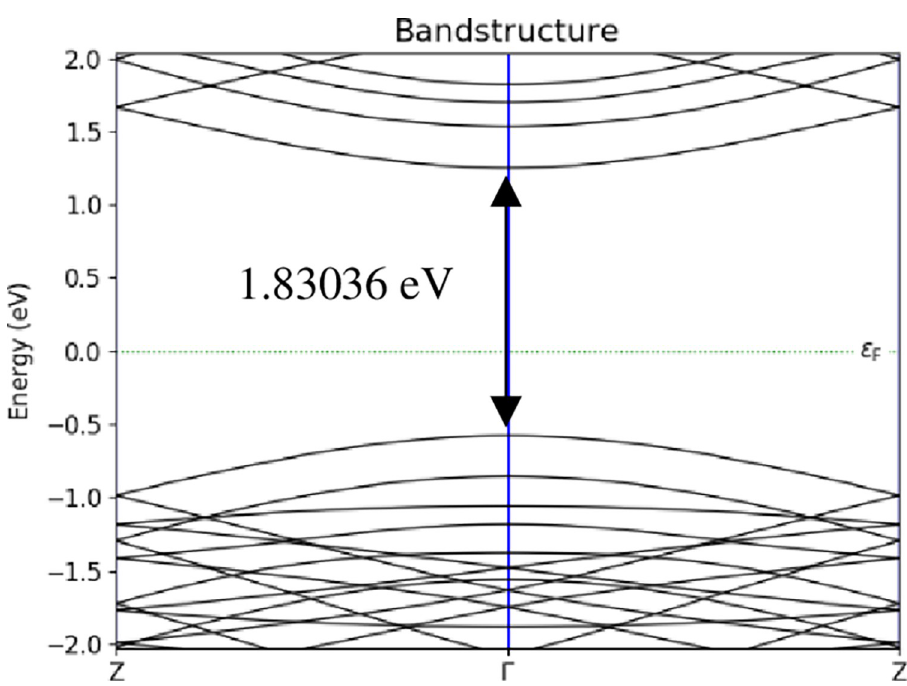
Fig 10. Energy band structures of 12-BC 2 NNR with different positions of H 2 gas molecules at both boron and nitrogen atoms for T = 298 K .